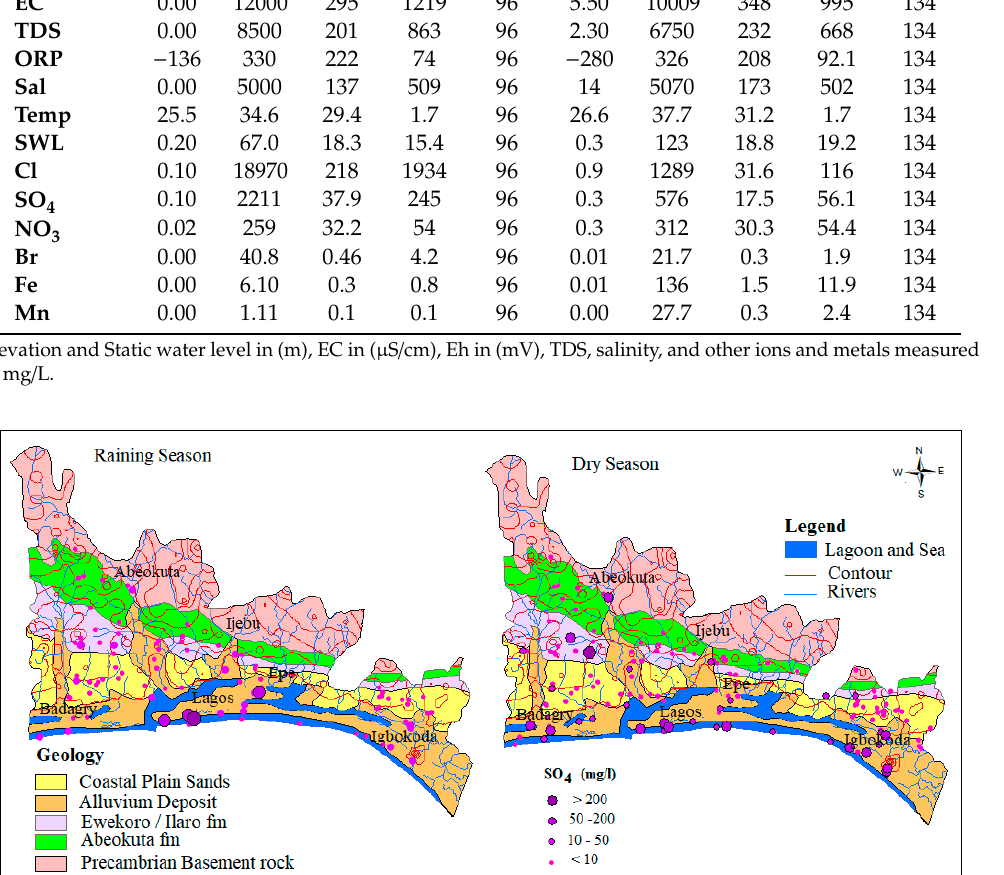
Table 1. Statistical summary of physicochemical parameters from water samples for both seasons. Param Min Max Aver Stdev N Min Max Aver Stdev N Elev − 1.00